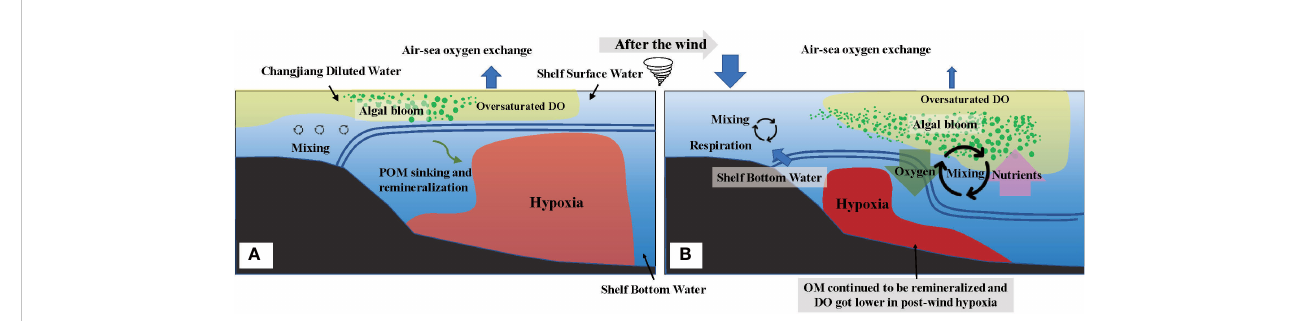
FIGURE 9 Conceptual model for the variations of the vertical distribution of dissolved oxygen (DO) under the wind event. Before the wind event (A) the strati fi cation strictly prevented the replenishment of DO. Algal blooms and DO are oversaturated above the strati fi cation, while hypoxia occurs below the strati fi cation as sinking particle organic matter remineralizing and consuming substantial DO. After the wind event (B) the vertical area of hypoxia decreased as downwards oxygen-rich surface water and enhanced algal bloom in the thickened mixed layer. However, bottom hypoxia intensi fi ed as further biological DO consumption negatively impacted the ventilation. Moreover, the fl ux of air – sea oxygen exchange increased with higher wind speed, especially at nearshore where the in fl ux of DO from air offset the DO de fi ciency.